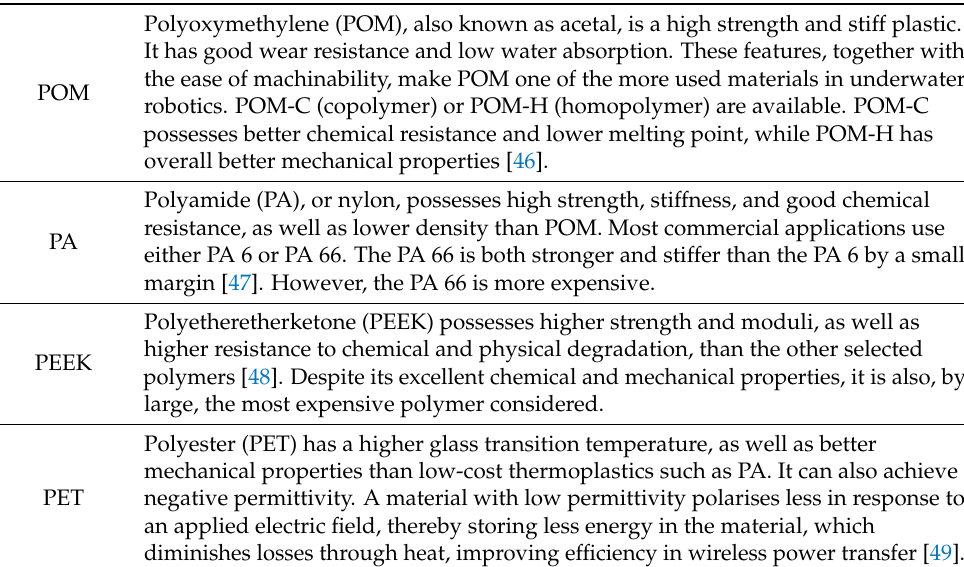
Table 2. Screened polymers for the material selection process of the box and